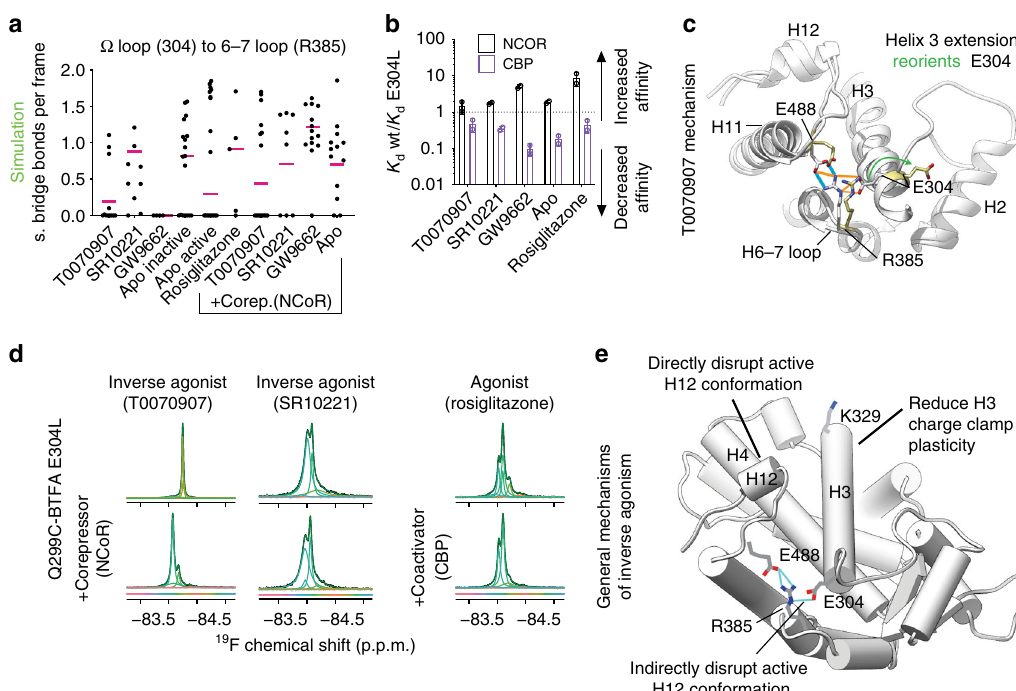
Fig. 7 General and T0070907 speci fi c mechanisms of inverse agonism. a Prevalence of the helix 6 – 7 loop (R385) to helix 3 (E304) salt-bridge is shown for the indicated complexes for individual cMD simulations started from representative structures from the lowest energy wells in the aMD potential energy landscapes (black circles). The Boltzmann average is shown by a magenta bar. b The change in af fi nity induced by mutation E304 is shown for the indicated complexes. The average (bar heights), standard deviation (error bars) and individual values (open circles) from two independent anisotropy experiments using protein from the same puri fi cation batch are shown. c Proposed intermediate state induced by T0070907 as illustrated by two crystal structures (1ZEO in khaki/white and 2PRG in white) where helix 3 extension leads to reorientation of E304 and disruption of the tripartite salt bridge network that stabilizes H12 in an active conformation. This reorientation upon helix 3 extension is observed in T0070907 and other simulations (Supplementary Fig. 4c). Blue indicates ideal hydrogen bonds, while orange lines indicate relaxed constraint hydrogen bonds (20° and 0.4 Å). d